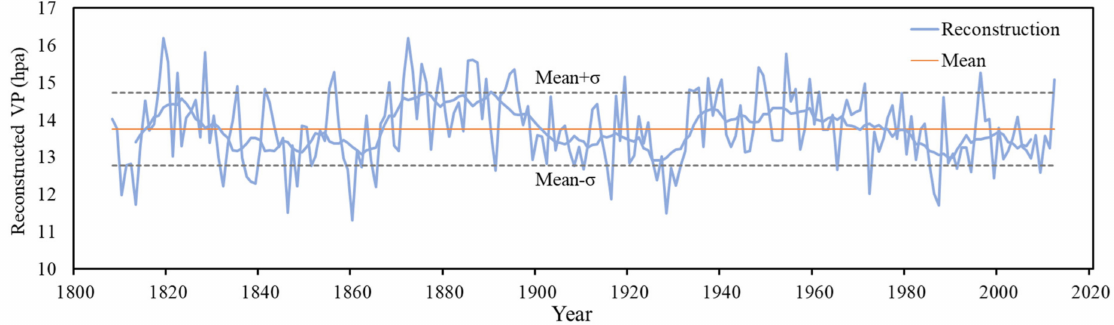
Figure 3. VP JA reconstruction during 1808–2012 in Ordos. The thick line is the 11-year moving averaged annual VP JA .